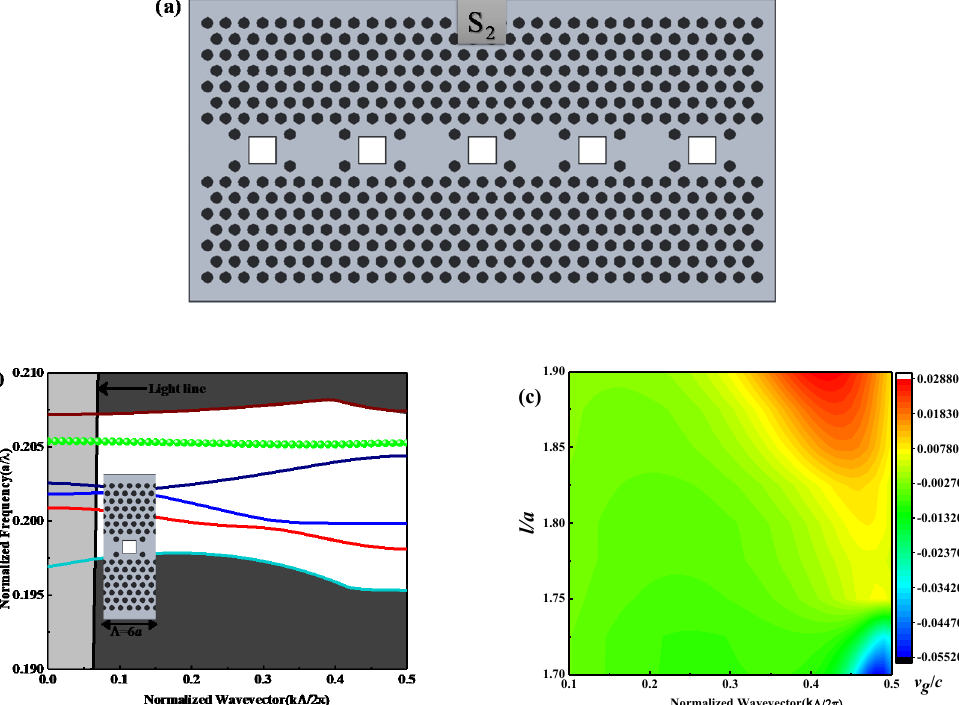
Figure 2. ( a ) Schematic structure of the proposed S2 SP-CS-SPCW geometry; ( b ) the dispersion curve for TM with l = 1.80 a , where the inset shows the supercell used for simulation; ( c ) the normalized group velocity ( v g / c ) contour map with l varying from 1.70 a to 1.90 a via normalized wavevector K .